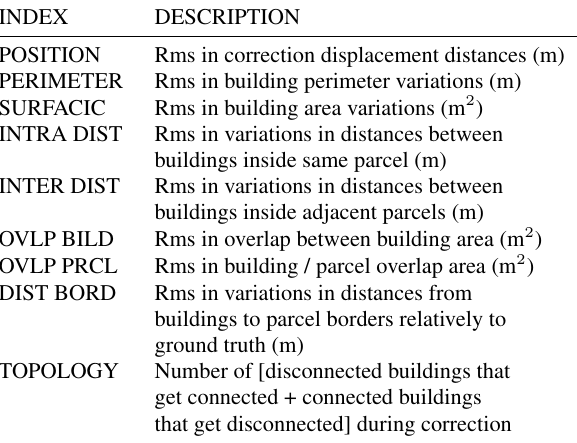
Table 1: Indexes to assess least squares algorithm performance